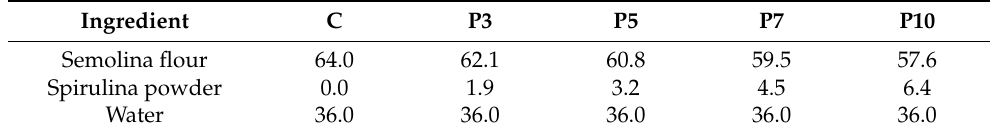
Table 5. Recipe ingredients of studied pastas [% content].